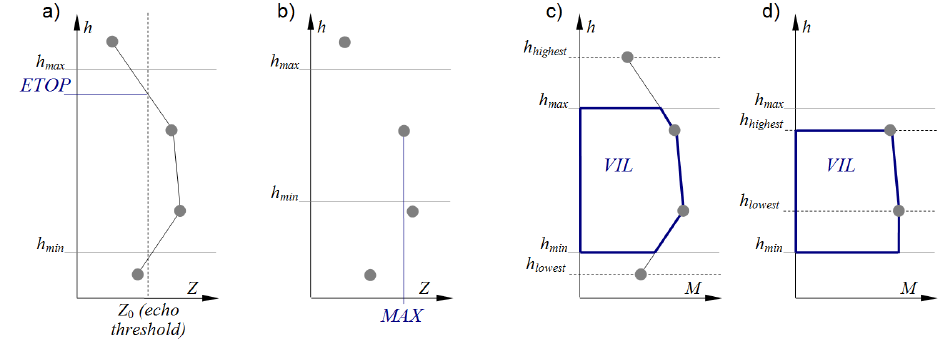
Figure 2. Schemes of generation of products from reflectivity Z values at particular PPIs: (a) echo top, ETOP; (b) maximum of reflectivity, MAX; ( c and d ) vertically integrated liquid water, VIL (cases for the highest measurement gate above and below the highest measurement